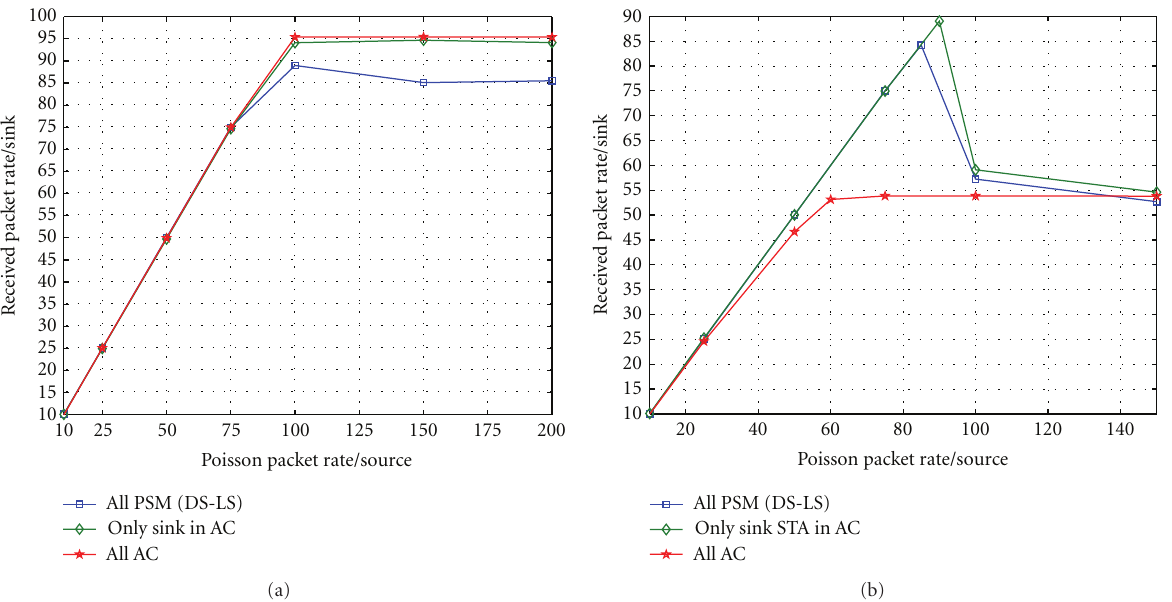
Figure 16: Throughput/sink for di ff erent packet rate. (a) For Setup 1 (no hidden node). (b) For Setup 2 (source STA1 and STA5 are hidden nodes).